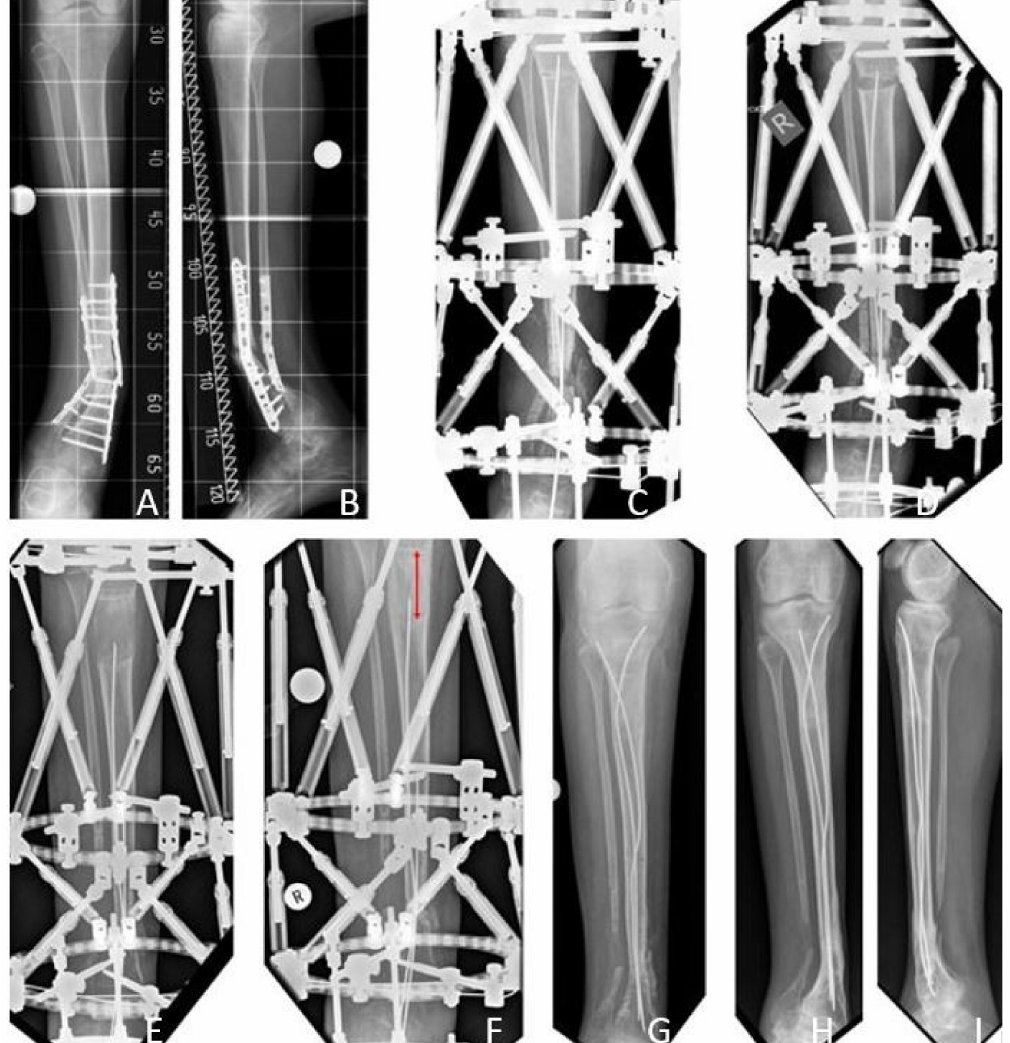
Figure 7. Results Group B. Fifteen-year-old male patient presenting CPT Paley type 4A with failed previous surgeries ( A : a.p. view; B : lateral view). After excision of 5 cm and acute compression ( C ), distraction osteogenesis of 57 mm was performed ( D , E ). The bone regenerate showed